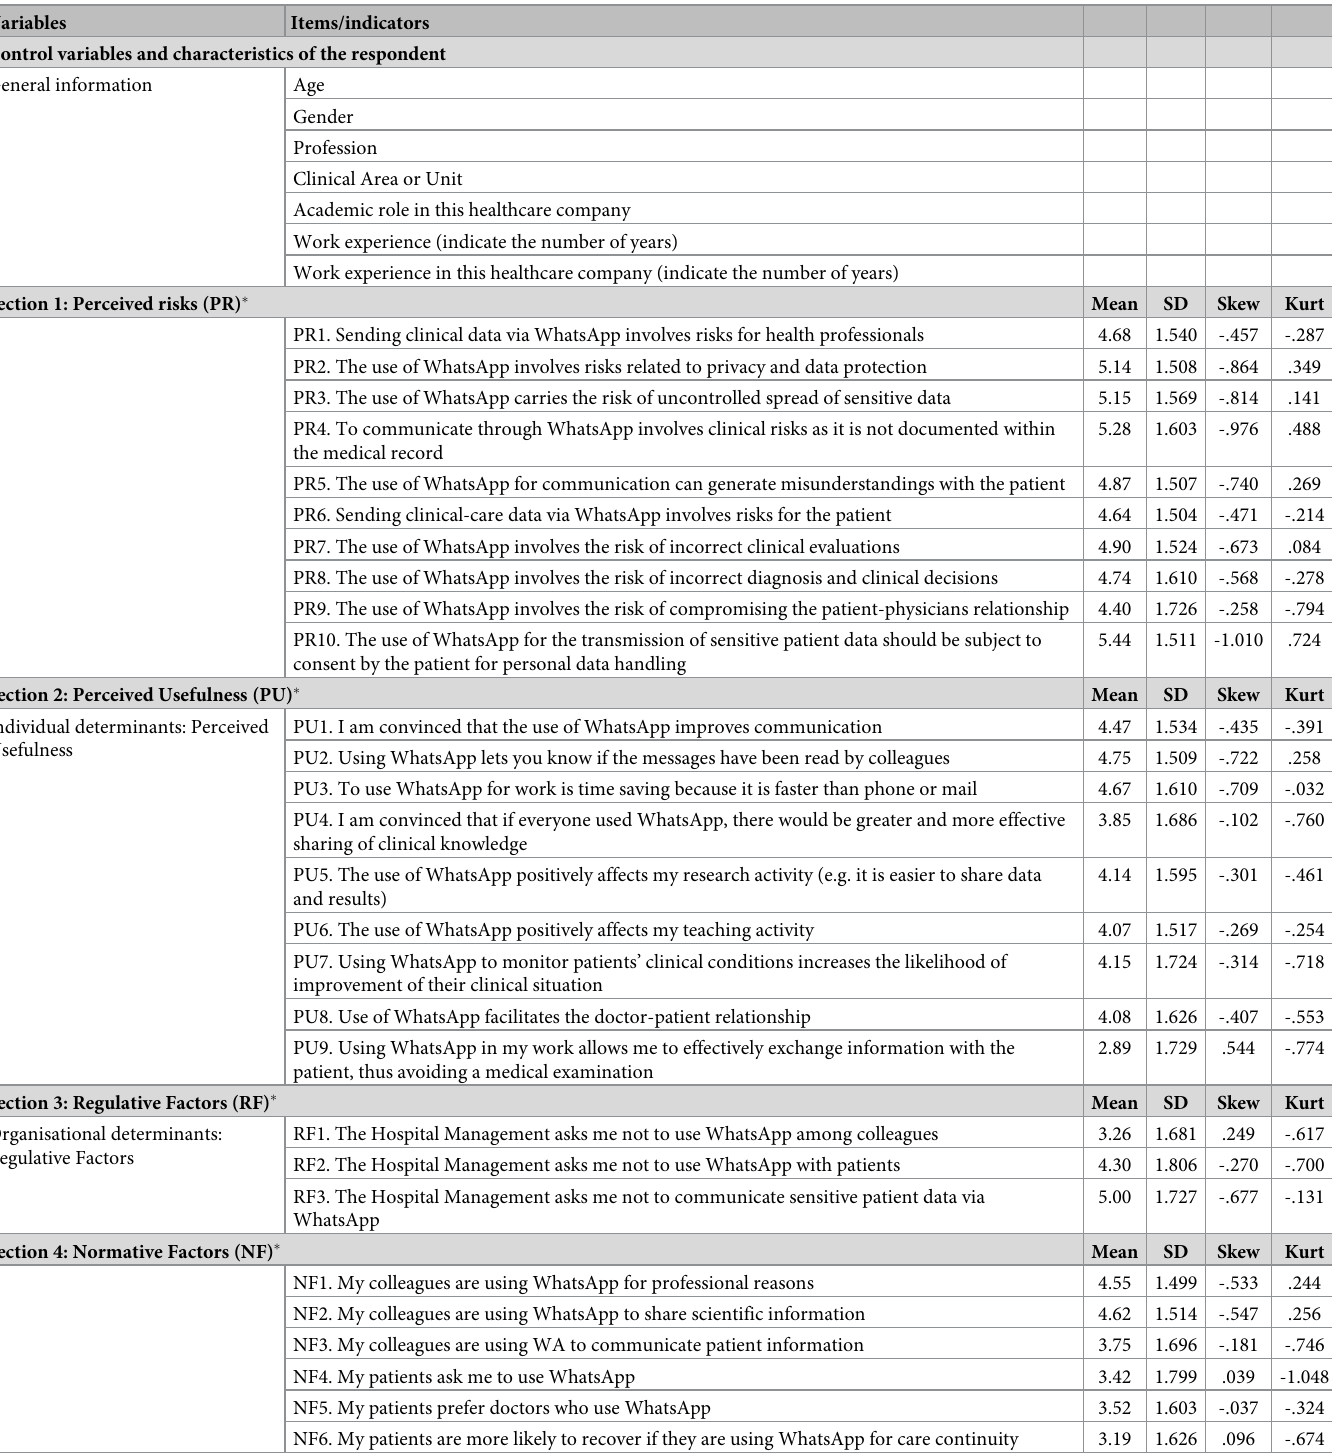
Table 1. Digital Innovation Adoption in Hospitals (DIAH) questionnaire